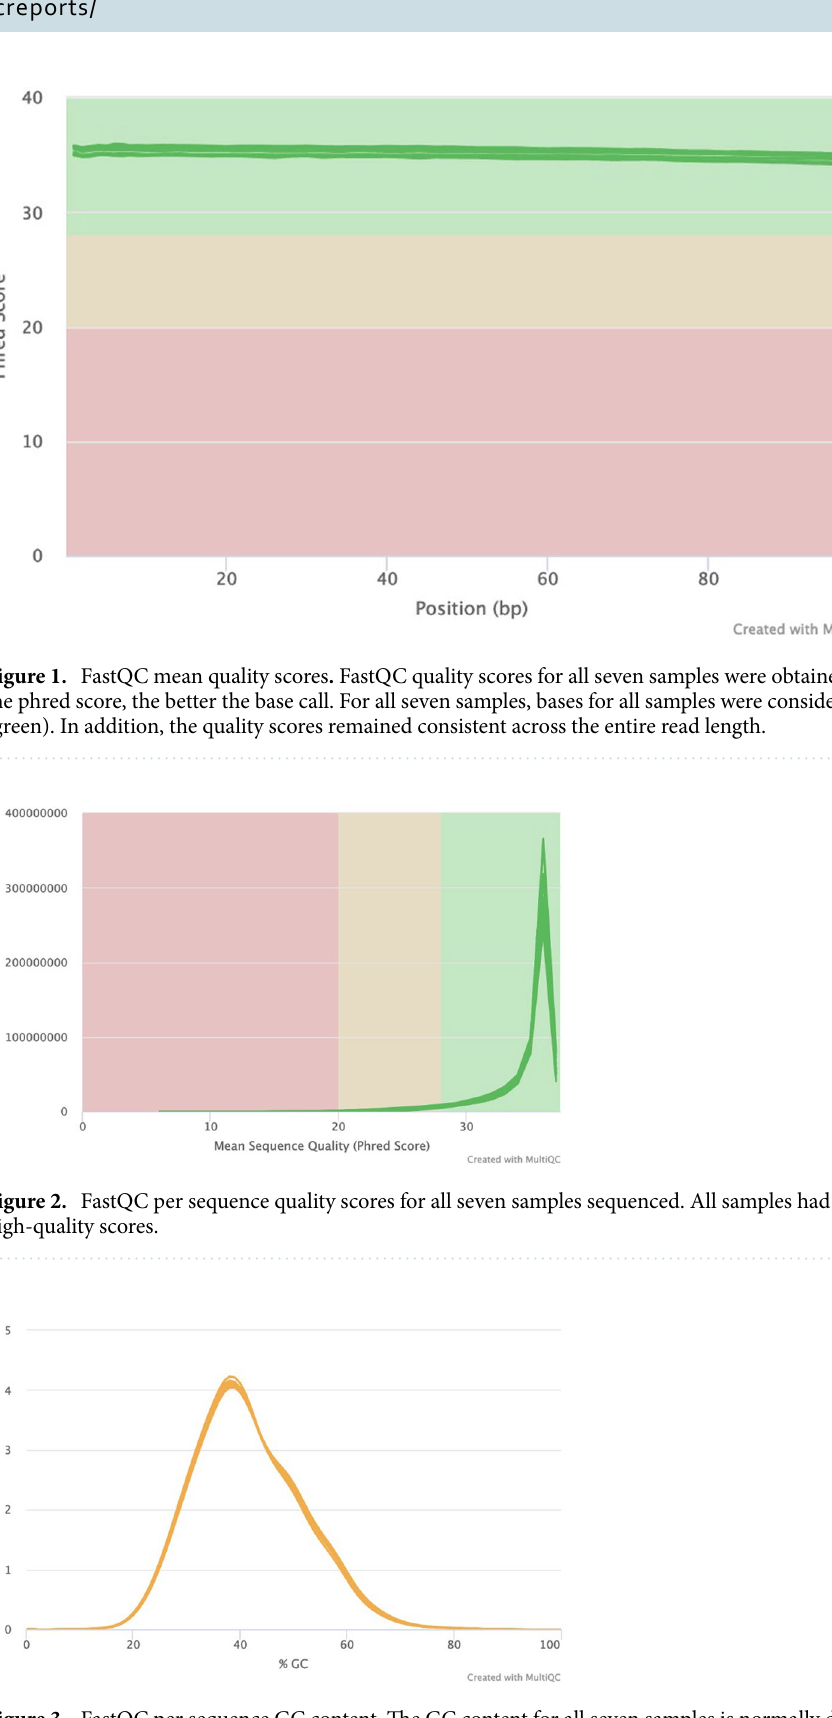
Figure 3. FastQC per sequence GC content. The GC content for all seven samples is normally